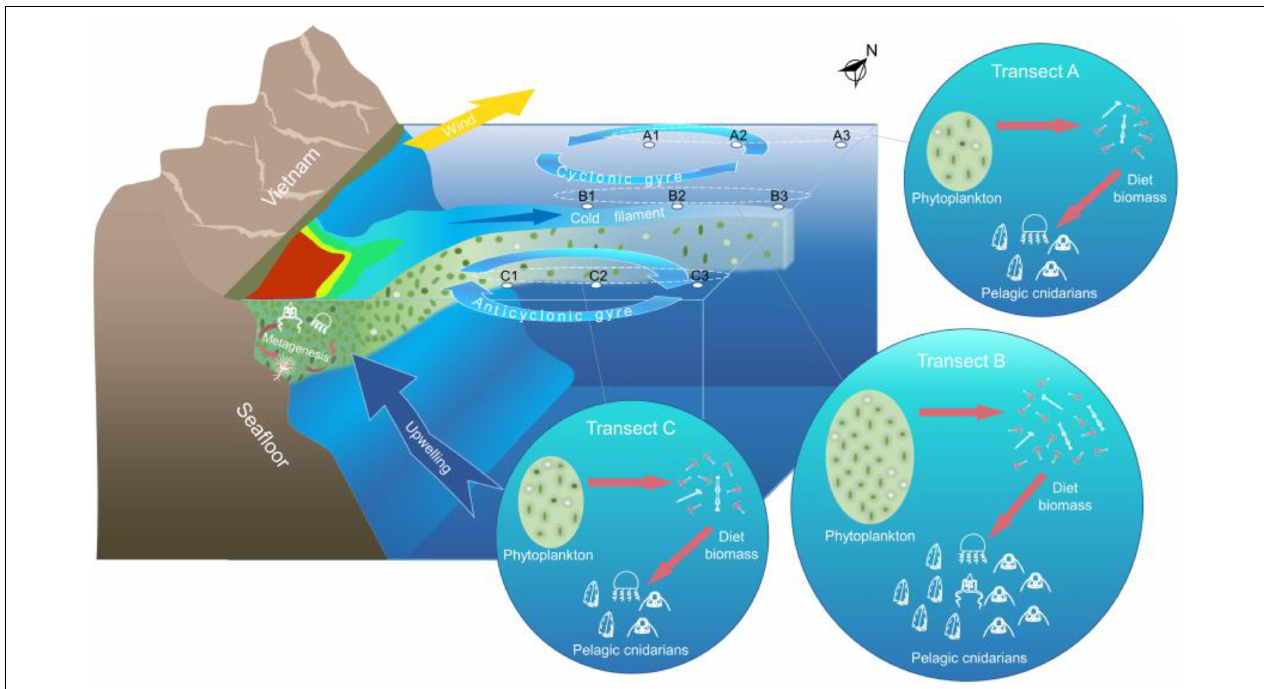
FIGURE 7 | Mechanism of control of wind-driven jet on the distribution of pelagic cnidarians in the midwestern South China Sea (SCS). The southwest monsoon induces offshore Ekman transport and brings upwelling. The cold upwelled water is transported offshore under the combined influence of the southwest wind jet and southern anticyclonic gyre, forming a clear cold filament. The nutrient-rich coastal water was carried to the WJR, thereby resulting in the increase in phytoplankton and diet zooplankton biomass. The biodiversity of meroplanktonic hydromedusae was increased due to the horizontal transport of the wind-driven jet, whereas these abundances showed no remarkable increase compared to the siphonophore and holoplanktonic hydromedusae because they cannot reproduce in the